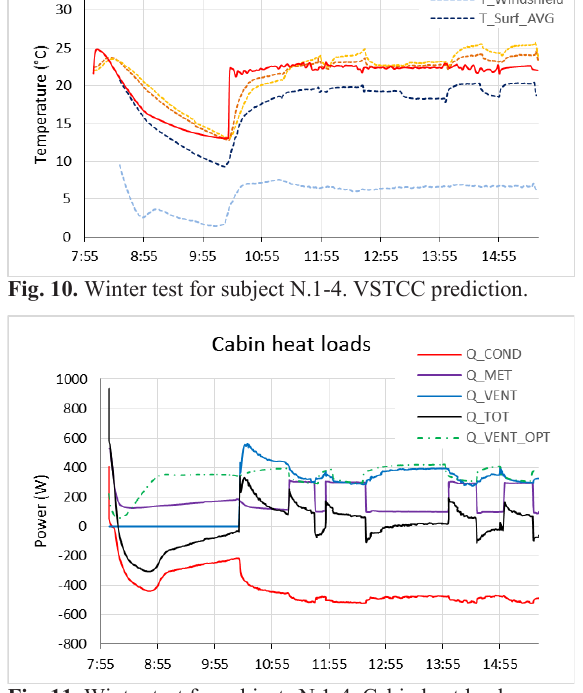
Fig. 11. Winter test for subjects N.1-4. Cabin heat